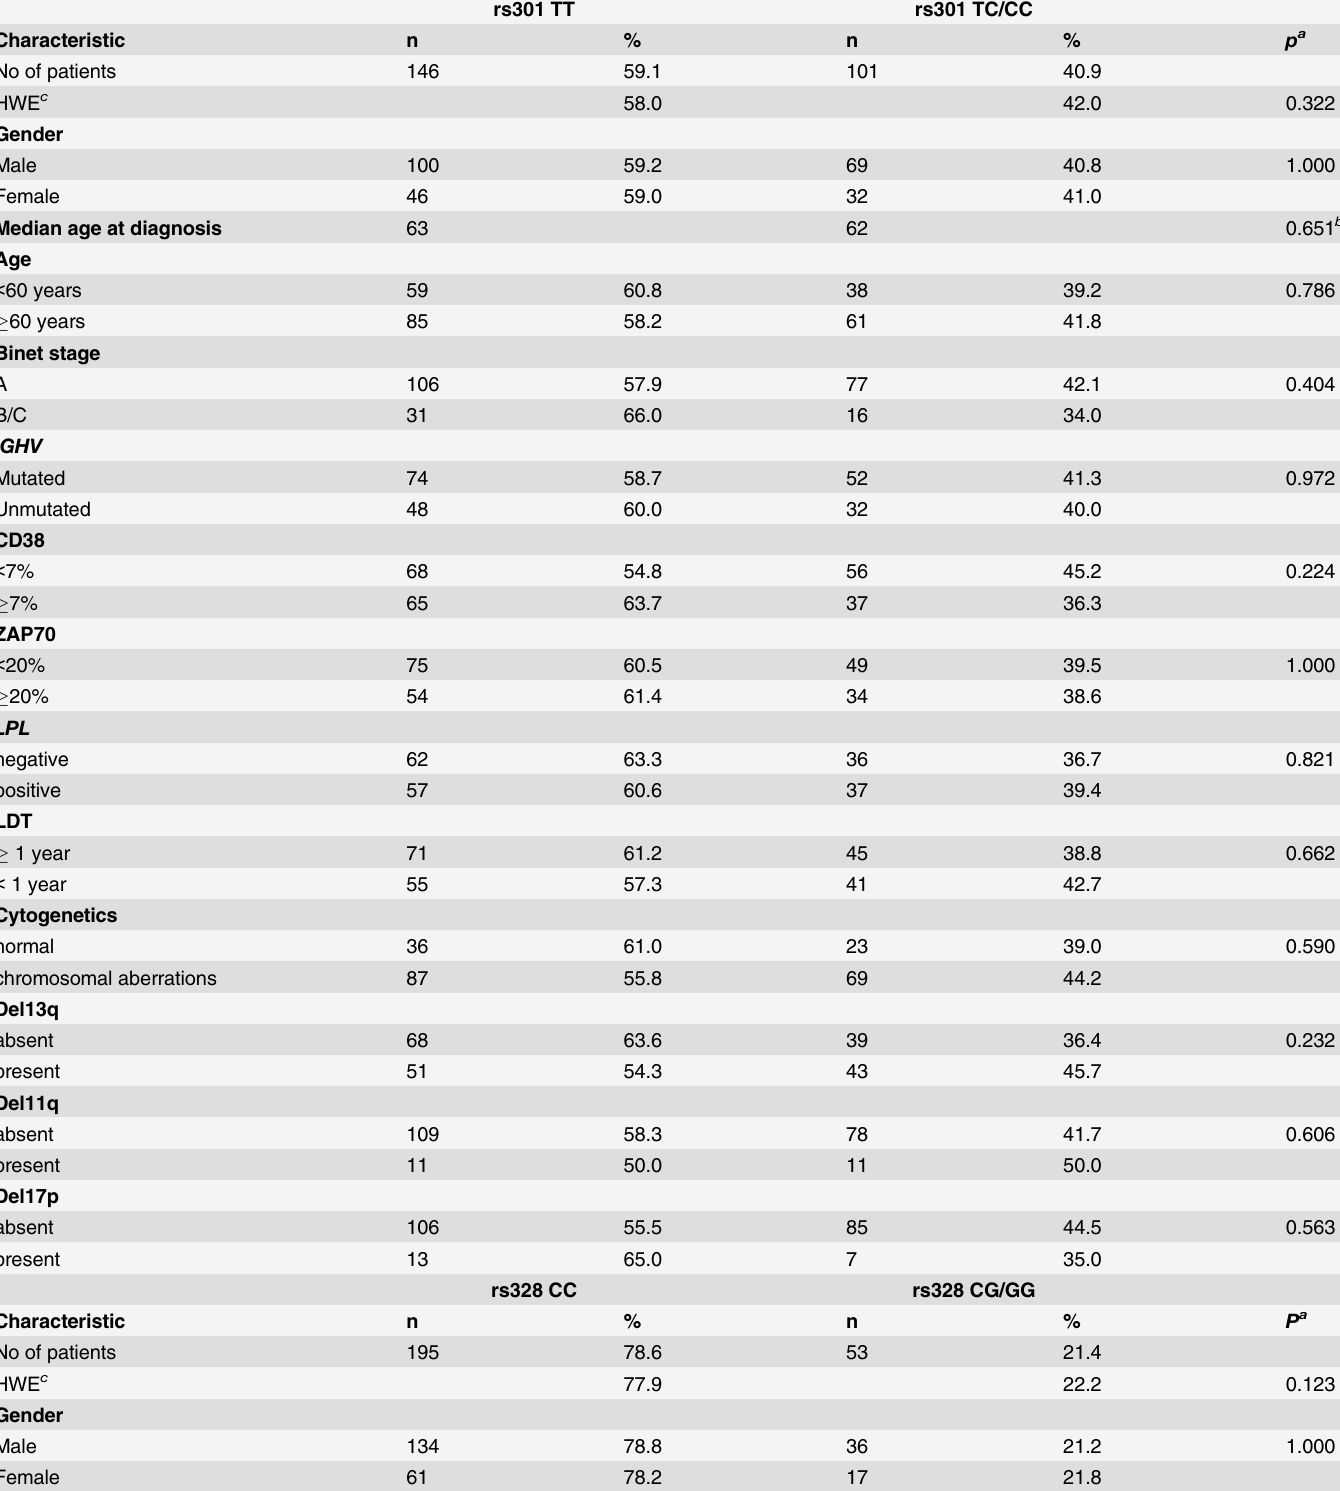
Table 2. Clinical and biological characteristics among LPL rs301, rs328 and rs13702